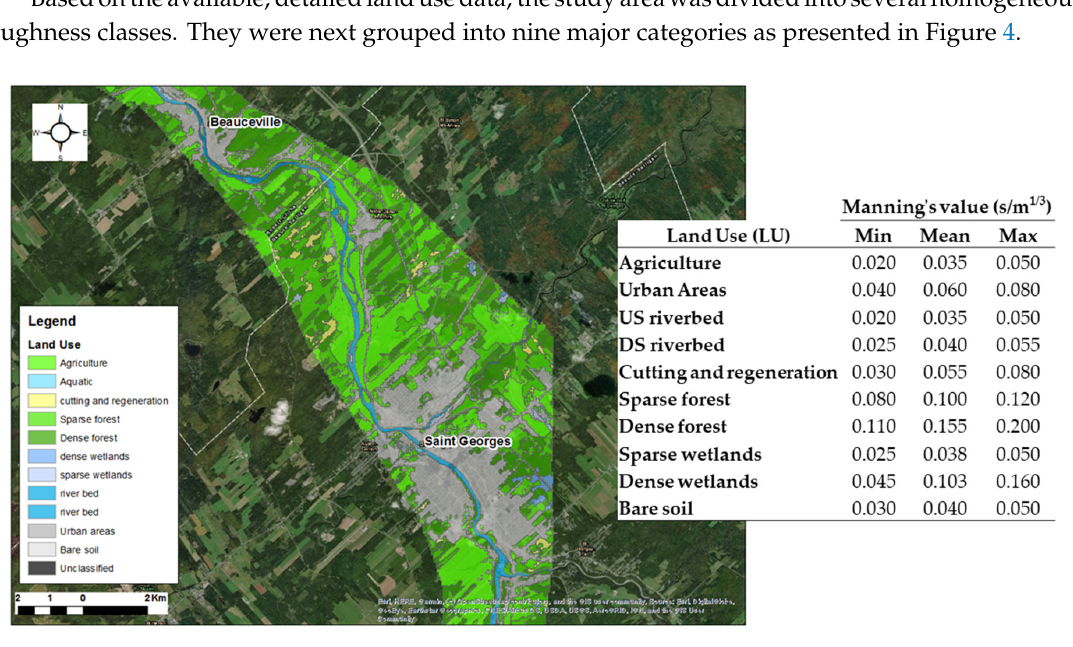
Figure 4. Roughness coe ffi cients mapping according to land use (LU) classification for the Chaudi è re